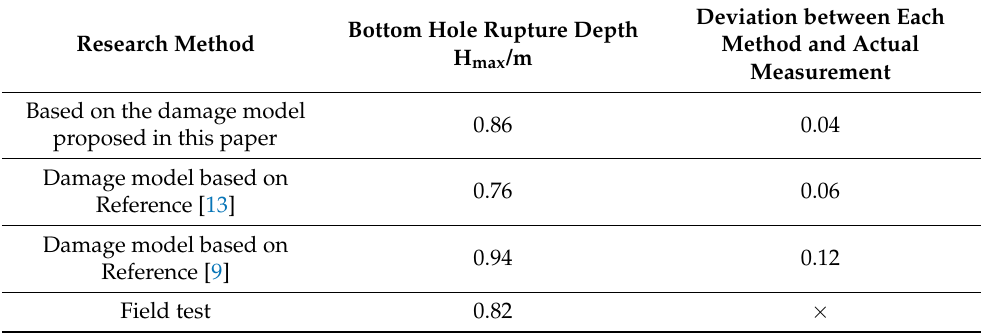
Table 2. Bottom fracture